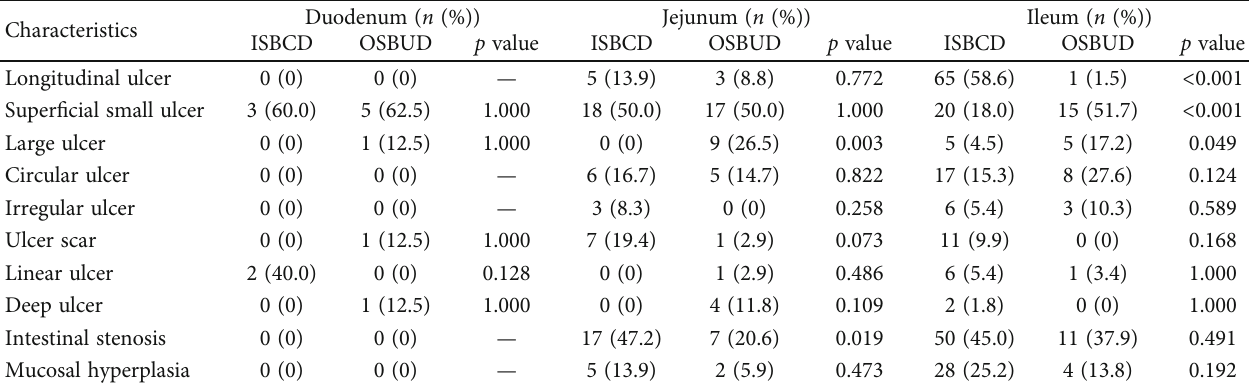
Table 6: Characteristics of ulcers in di ff erent intestinal